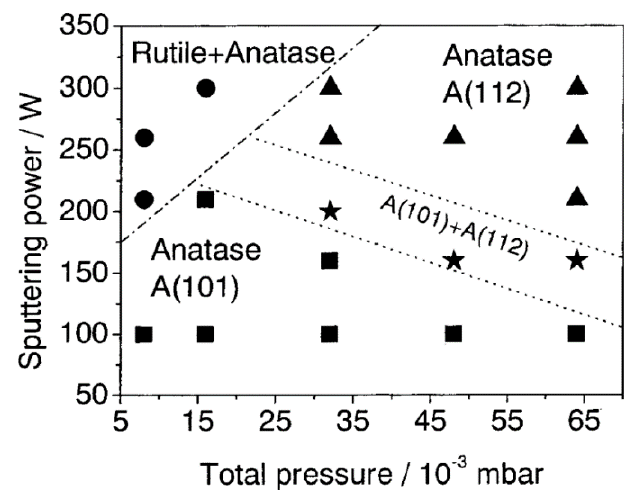
Figure 5. Schematic phase diagram of TiO 2 films defined by sputtering power. The diagram is compiled from experimental data obtained from XRD: ( ■ ) (101)-preferred orientation anatase, ( ▲ ) (112)-preferred orientation anantase, ( ★ ) anatase with almost equivalent (101) and (112) peaks, and ( ● ) rutile and anatase mixture.Reprited with permission from [60], Copyright 2004, IOP Publishing.